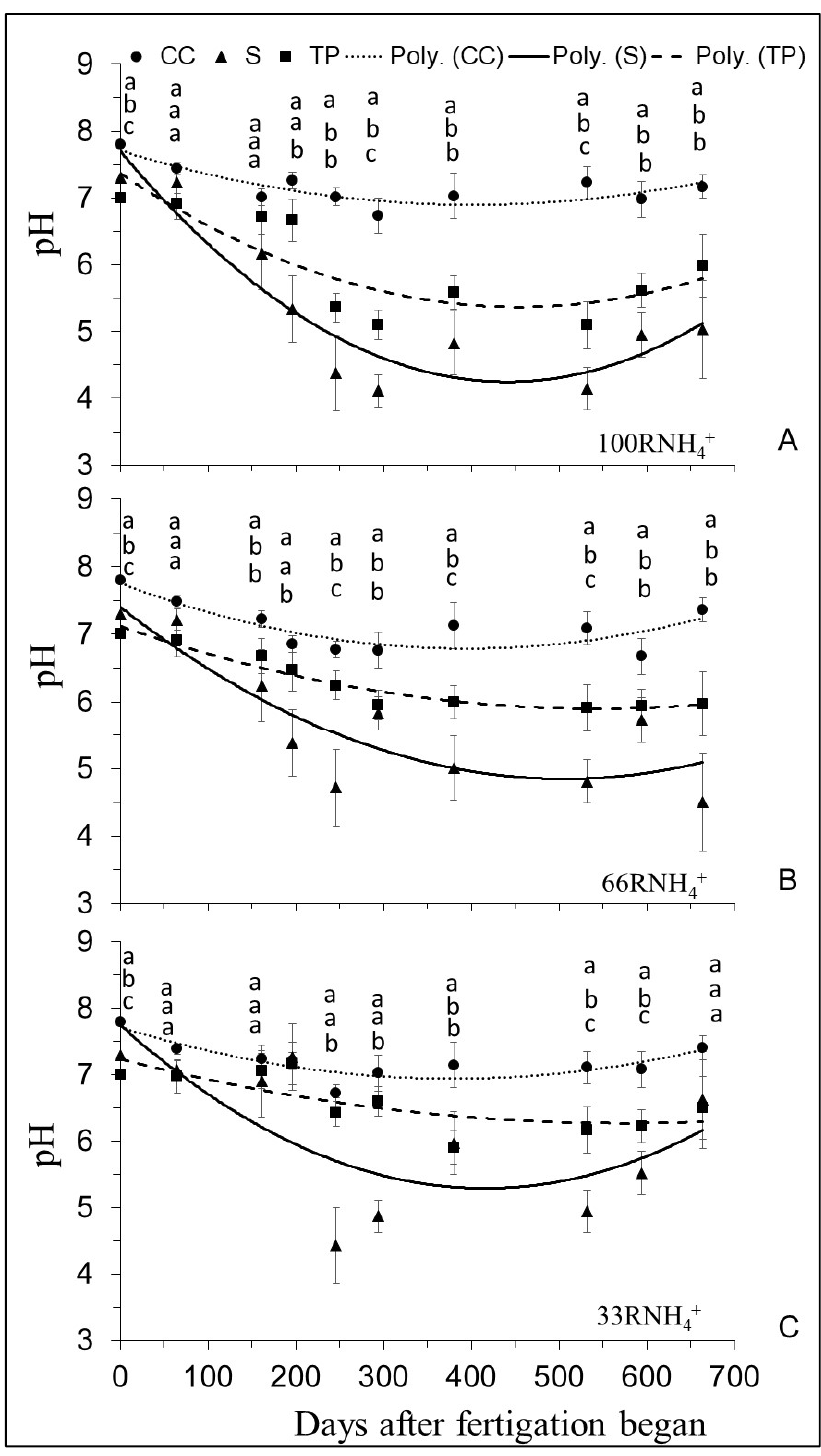
Figure 2. Effect of the growth medium [tuff/peat mixture (TP, squares), sandy soil (S, triangles) and calcareous, clayey soil (CC, circles)] on the pH measured directly in the growth medium over the course of the experiment (26 November 2015 to 8 November 2017) presented for treatments with three different proportions of N-NH 4+ out of the total applied inorganic N [RNH 4+ , 100% ( A ), 66% ( B ) and 33% ( C )]. Means for growth-medium treatments at each measurement point in each panel followed by the same letter do not differ according to LSMeans Tukey’s HSD test; n = 6, p = 0.05. The best-fitting second-order polynomial equation for each treatment and their coefficients and statistical parameters are presented in Table 3.